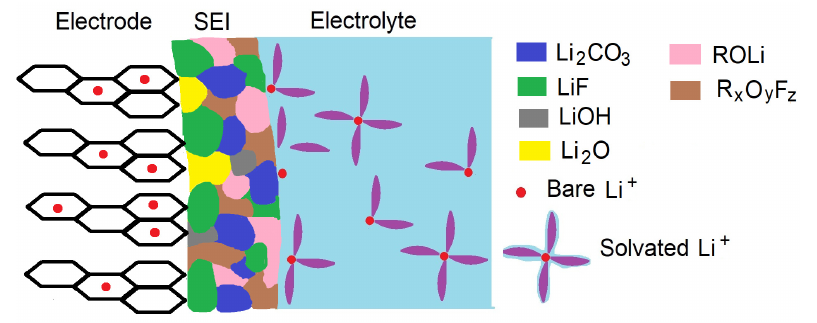
Figure 1. Schematic of SEI functioning.